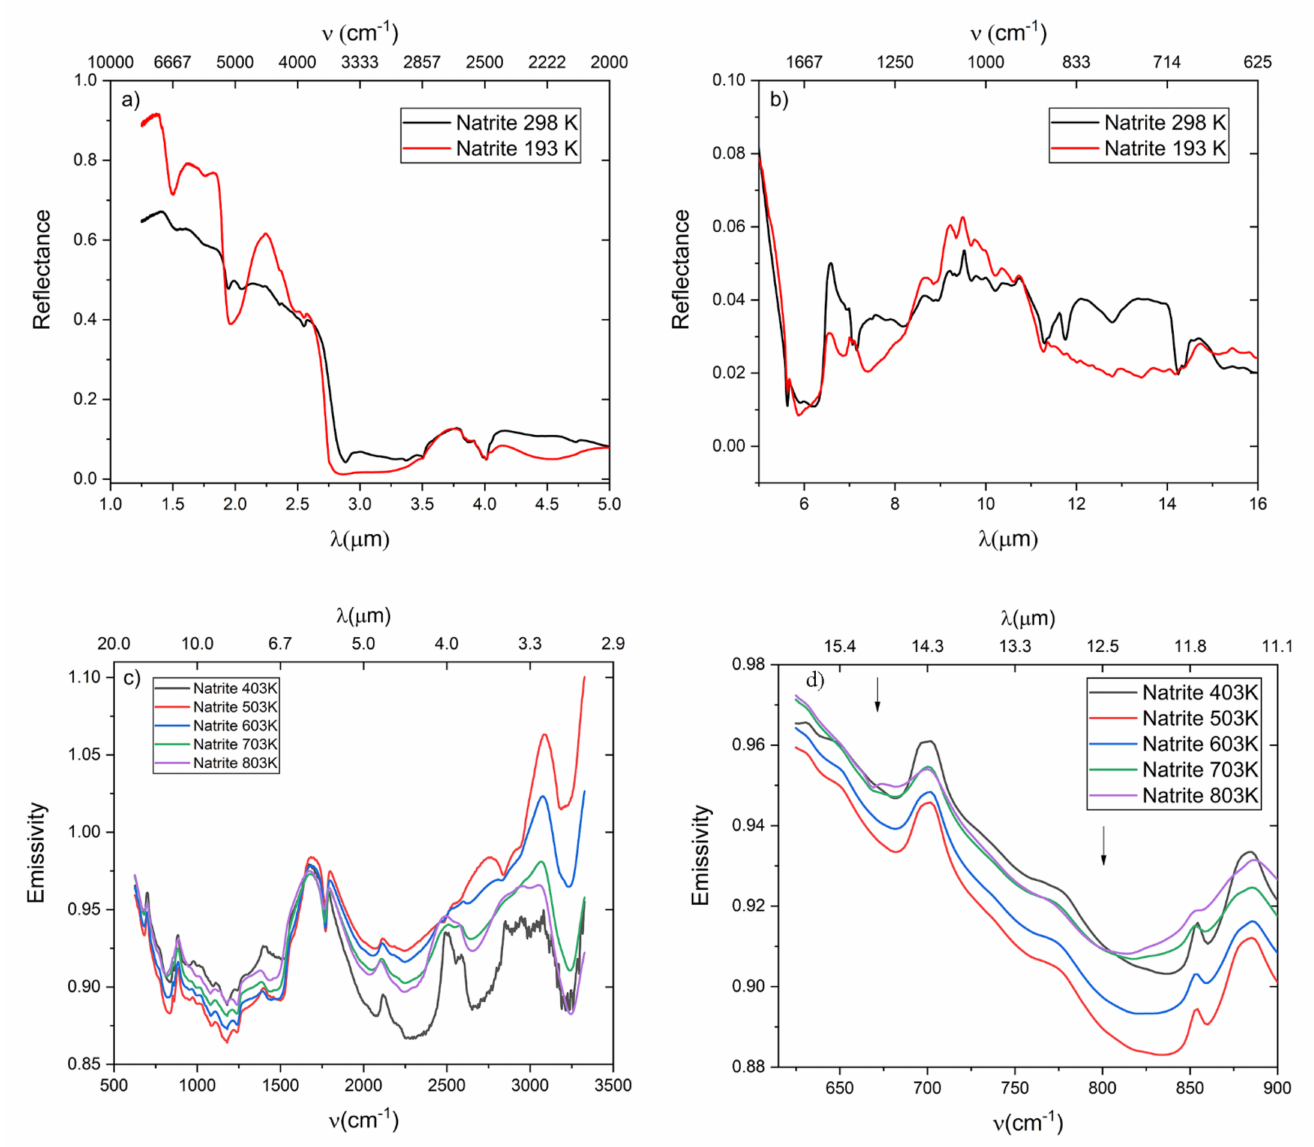
Figure 2. Reflectance spectra at room temperature and 193 K ( a , b ) and emissivity measurements from 403 to 803 K ( c ) of natrite. Focus on the absorption bands cantered at ≈ 669 and ≈ 794 cm − 1 (denoted by arrows) for the emissivity spectra of sample defined natrite Na 2 CO 3 ( d